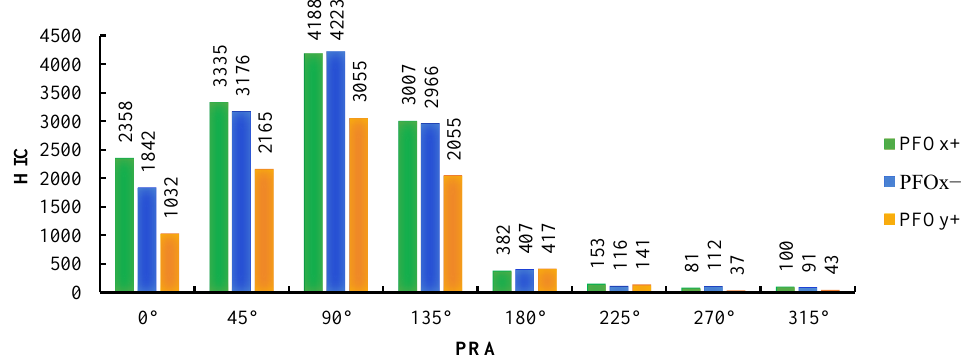
Figure 6. HIC values caused during head-to-ground contact.